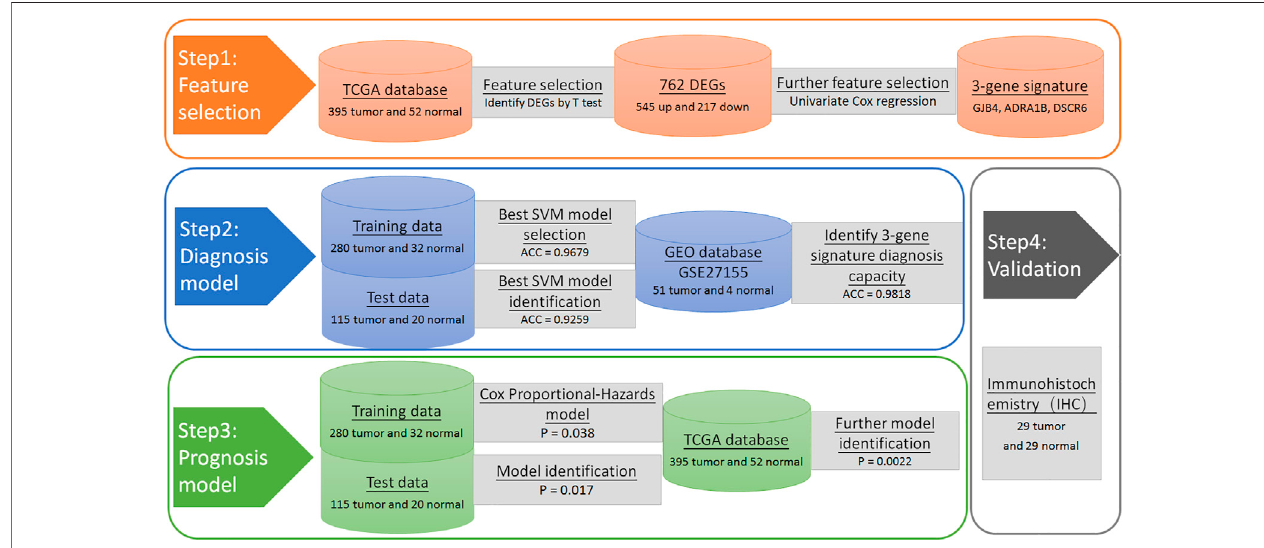
FIGURE 1 | Flowchart of PTC prognostic signatures generation and validation